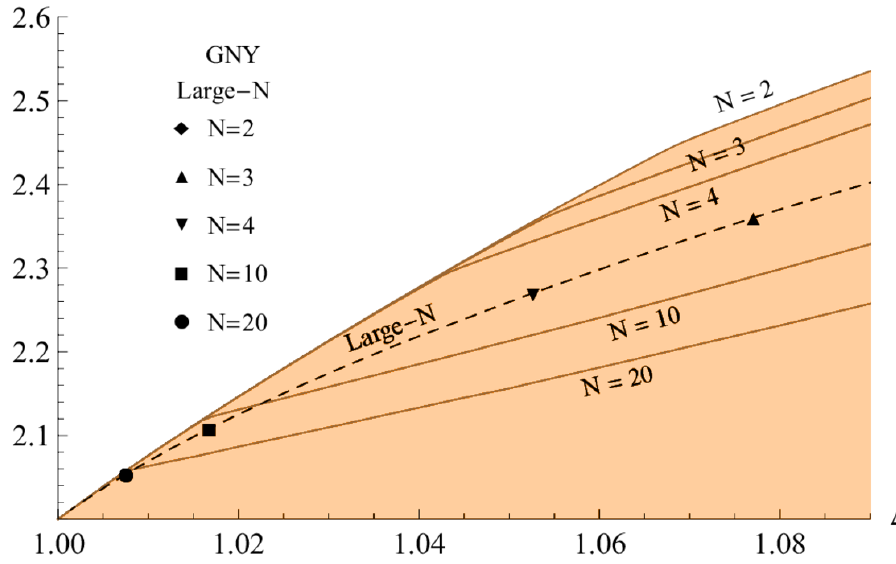
Figure 1 . Upper bounds on the scaling dimension of the lowest-lying parity-odd O ( N ) symmetric- traceless tensor, (cid:1) (cid:27) , for a unitary CFT containing fermions with scaling dimension (cid:1) . We focus T on the cases N = 2 ; 3 ; 4 ; 10 and 20. The black symbols show the estimated values of the scaling dimensions (cid:1) and (cid:1) (cid:27) obtained from the large- N expansion up to O (1 =N 4 ) corrections [28]. For T N = 10 ; 20 we note strong agreement. This (cid:12)gure is a zoomed in version of (cid:12)gure